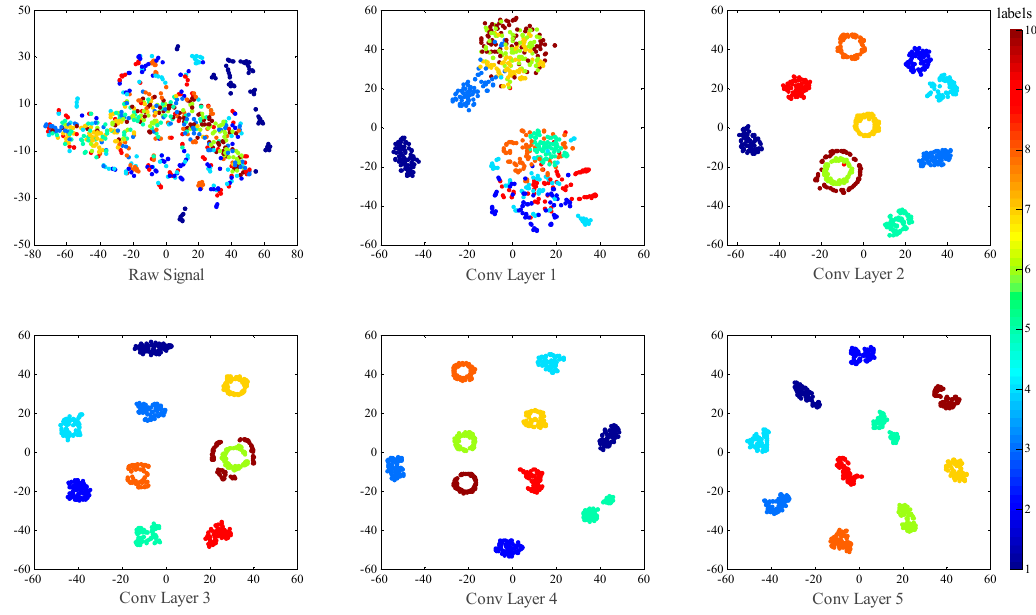
Figure 16. Visualization of the feature distribution of all the test samples with no noise extracted from each convolutional layers and the last fully-connected layer via t-SNE method.